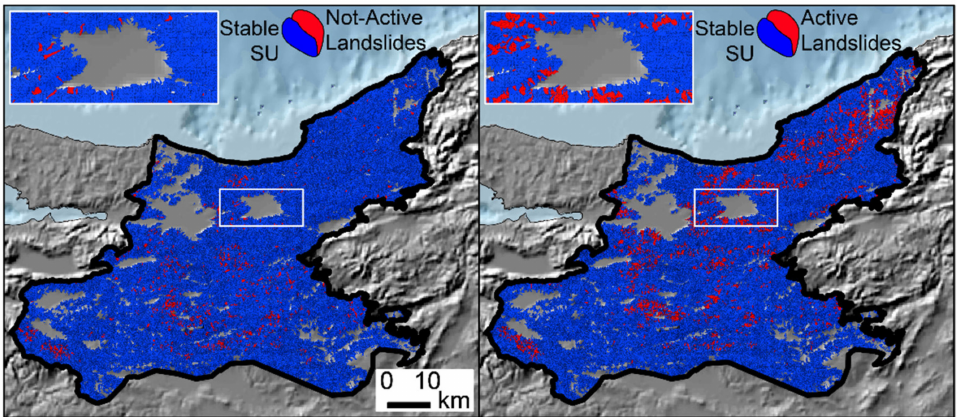
Figure 2. Slope Unit partition of the study area: SUs containing inactive ( left ) and active ( right ) landslides are shown. The sub-panels show a detail for a small region, in which it is possible to observe the flat areas excluded by the SU calculation (see Section 4.2 for explanation). The legend is valid for the whole area and zoomed